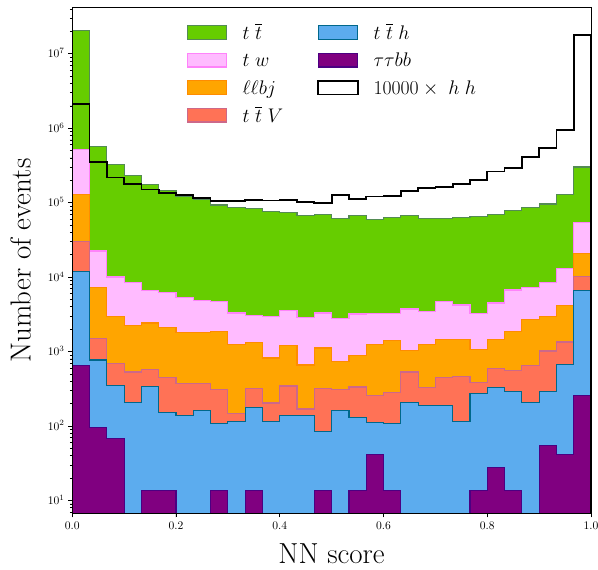
Figure 13 . NN score for CNN with V 21-kin + V ( C,N,‘,ν H ,ν T )